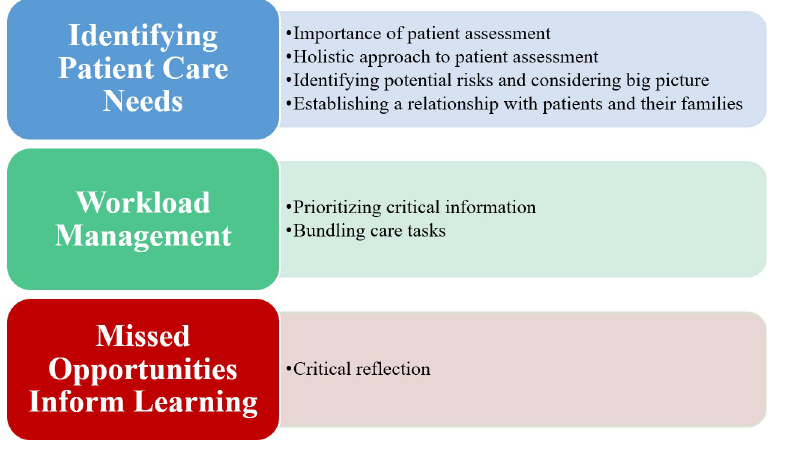
Fig 2. Interview themes and